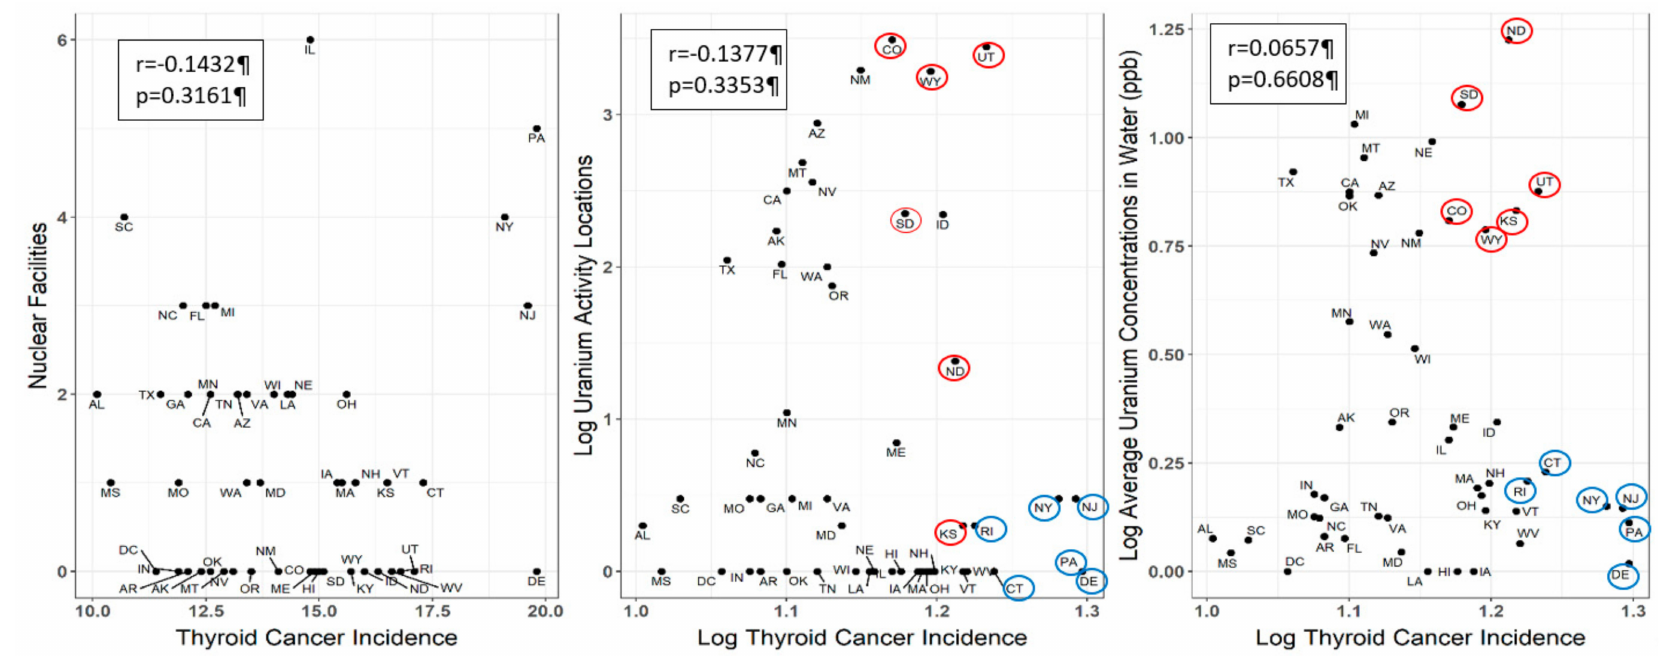
Figure 4. Spearman correlation of age-adjusted thyroid cancer incidence rates per state and sources of uranium exposure, including nuclear facilities, uranium activity locations and uranium concentrations in water. Note: The red-circled states are the states with high age-adjusted thyroid cancer incidence rates and high number of uranium activity locations and high uranium concentrations in water. The blue-circled states are the states with the highest age-adjusted thyroid cancer incidence rates in the